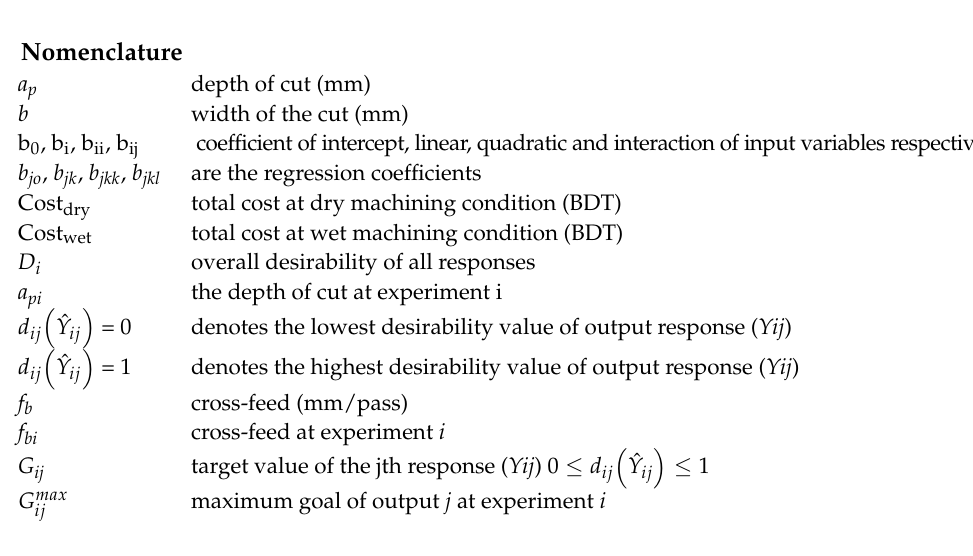
parameter; Table S3: Formula for calculating wheel velocity and MRR ; Table S4: Raw data for the regression analysis under dry condition; Table S5: Raw data for the regression analysis under wet condition; Table S6: Data table showing design of experiment; Table S7: Data table showing the calculation of temperature using RSM equations; Table S8: Data table showing cost calculation under dry and wet condition using RSM equations; Table S9: Data table showing the calculation of desirability at dry condition; Table S10: Data table showing the calculation of desirability at wet